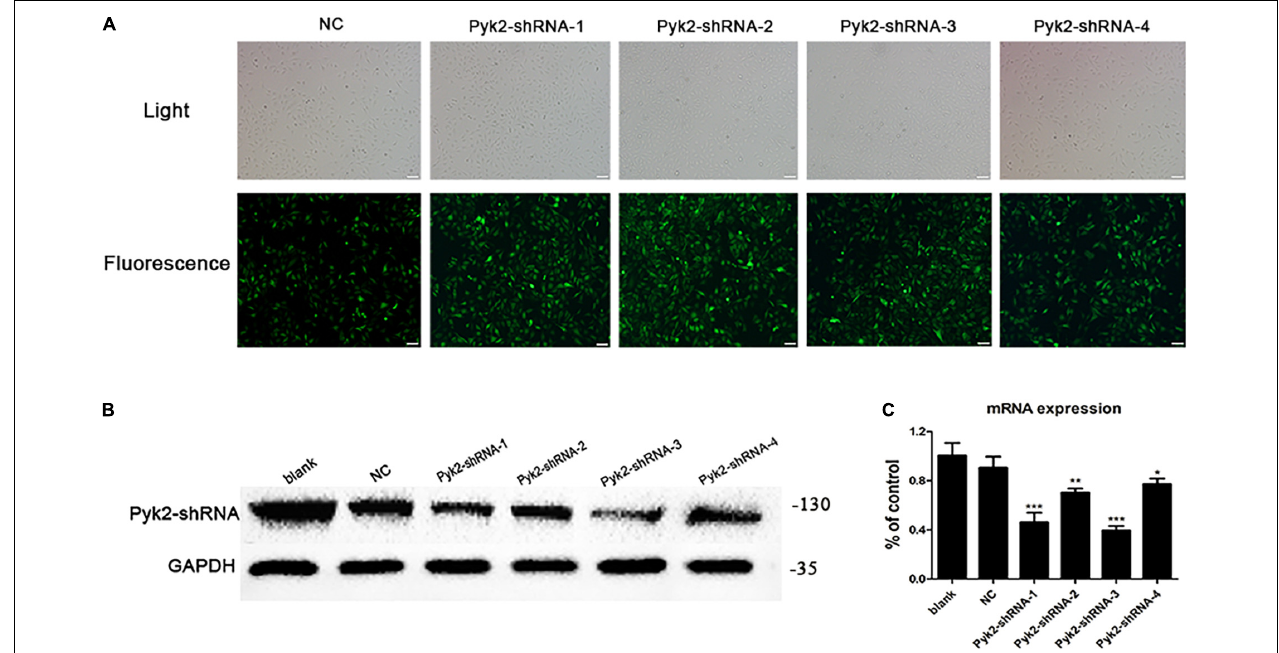
FIGURE 7 | Pyk2-shRNA lentivirus transfection efficiency observation of human umbilical vein endothelial cells (HUVECs). (A) Fluorescence results of HUVECs infected with different targeting sequences of Pyk2 gene ( × 200). Scale bar: 100 µ m; target sequence (NC: GCTTCGCGCCGTAGTCTTA; Pyk2-shRNA-1: GCTACTTGCCAGAAGACTTCA; Pyk2-shRNA-2: GCAGCATAGAGTCAGACATCT; Pyk2-shRNA-3: GCTGTACTCACTGCAGATATG; Pyk2-shRNA-4: GCGGCAAATCCTGGACAAACA). (B) Protein expression results of HUVECs infected by different Pyk2-shRNA lentivirus. (C) mRNA expression results of